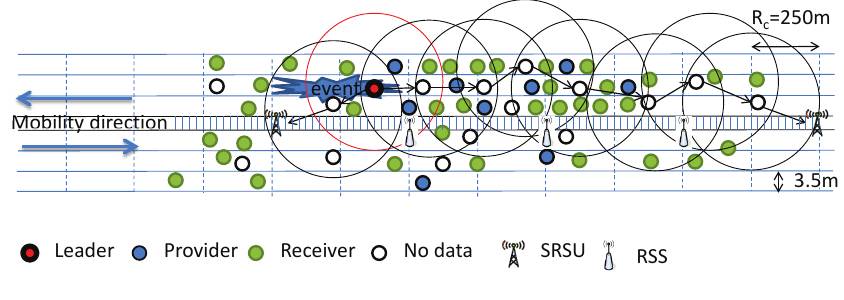
Figure 10. Selection of next Leader when vehicles move along the same direction.